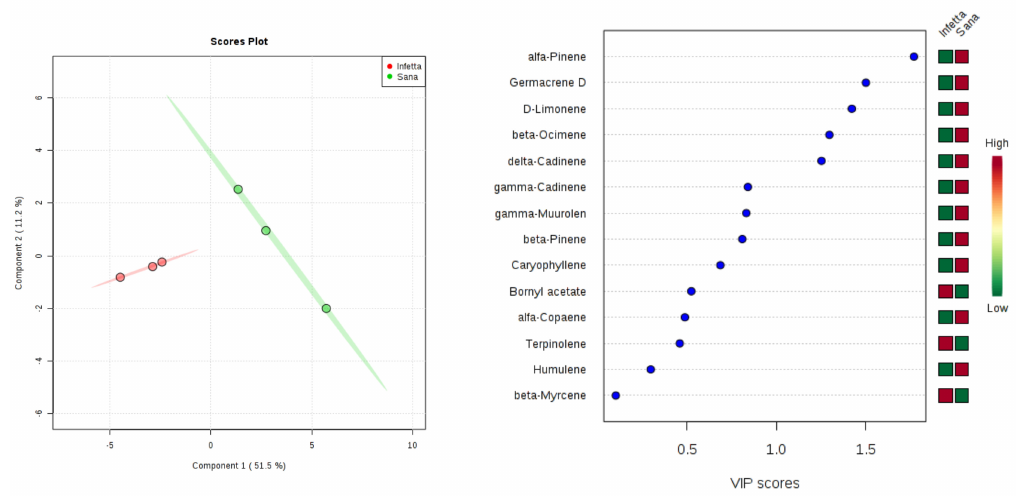
Figure 14. Partial least squares discriminant analysis applied to the Sampling #5 (PROCE-2) in Canolo. Parameters and symbols as in Figure 4.